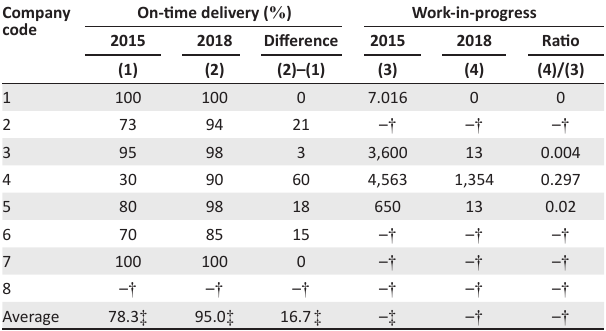
TABLE 5: Change in the proportion of on-time delivery ( % ) and work-in-progress between before (2015) and after (2018) Kaizen training. Company On-time delivery ( % code